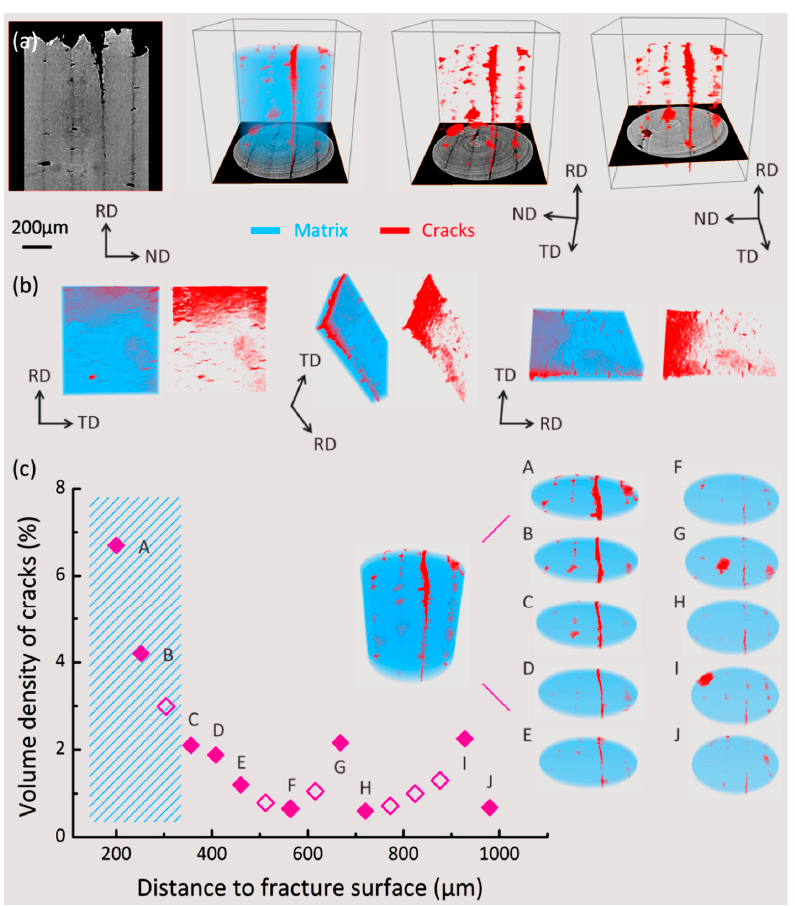
Figure 5. 3D characterizations of the fracture behavior in layered α 2 -Ti 3 Al / α -Ti composite [31]: ( a ) reconstructed slices and crack distribution observed along TD; ( b ) morphologies of the cracks abstracted from ( a ); and ( c ) quantitative results of the volume density of cracks plotted as a function